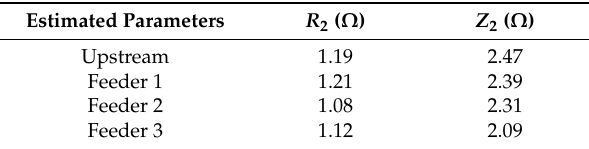
Table 9. Estimation results for the circuit parameters.